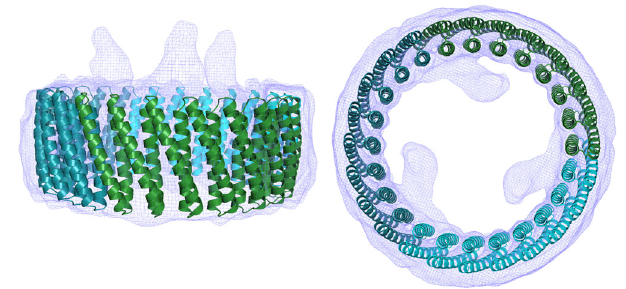
Fig. 6 CryoEM single-particle reconstruction of tcTRP24 8 SS. Two different views of the electron density map superposed with the original model. The three-strong features extending from equivalent positions around the tcTRP particle correspond to N-terminal poly-histidine af fi nity tags and linkers extending from the N-terminus of each protein subunit (an